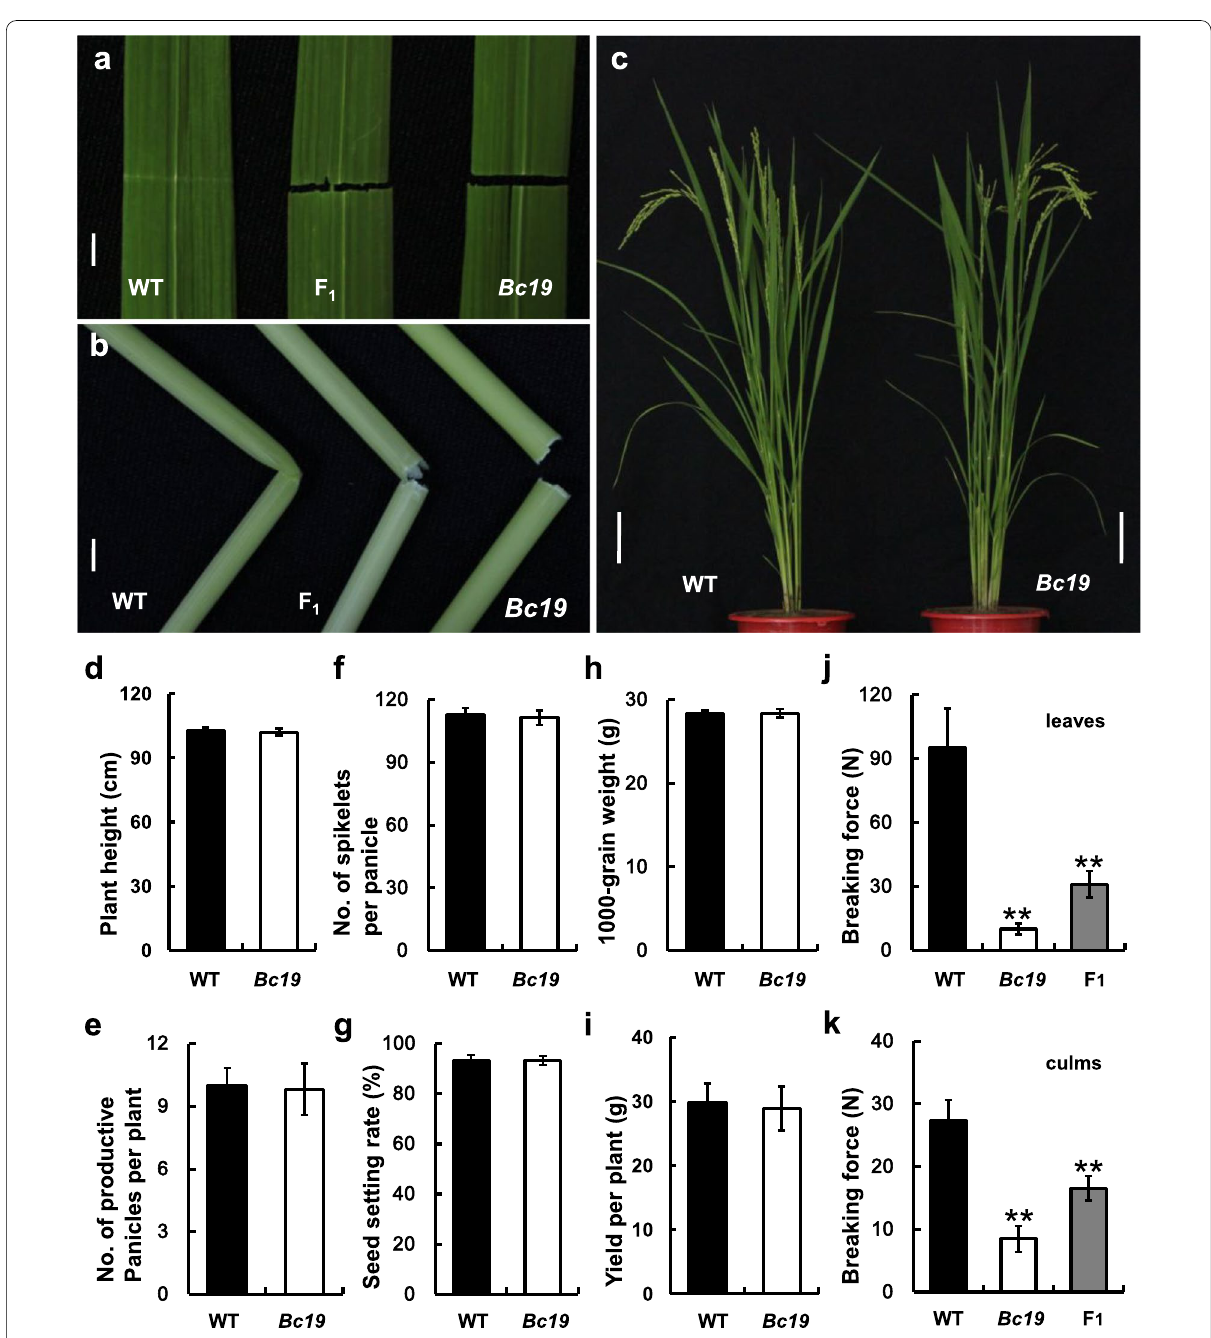
Fig. 1 Comparison of phenotypes ( a – c ), major agronomic traits ( d – i ) and breaking force ( j leaves and k culms). a Leaf. b The second internode of main culm from the top. c Plants two weeks after heading. Bars represent standard deviations of three independent measurements. WT: Nipponbare; F 1 : Obtained from mutant Bc19 crossing with WT. Double-asterisk signifies statistically significant difference compared to the wild type at p < 0.01. Scale bar equals 1 cm in a – b and 10 cm in